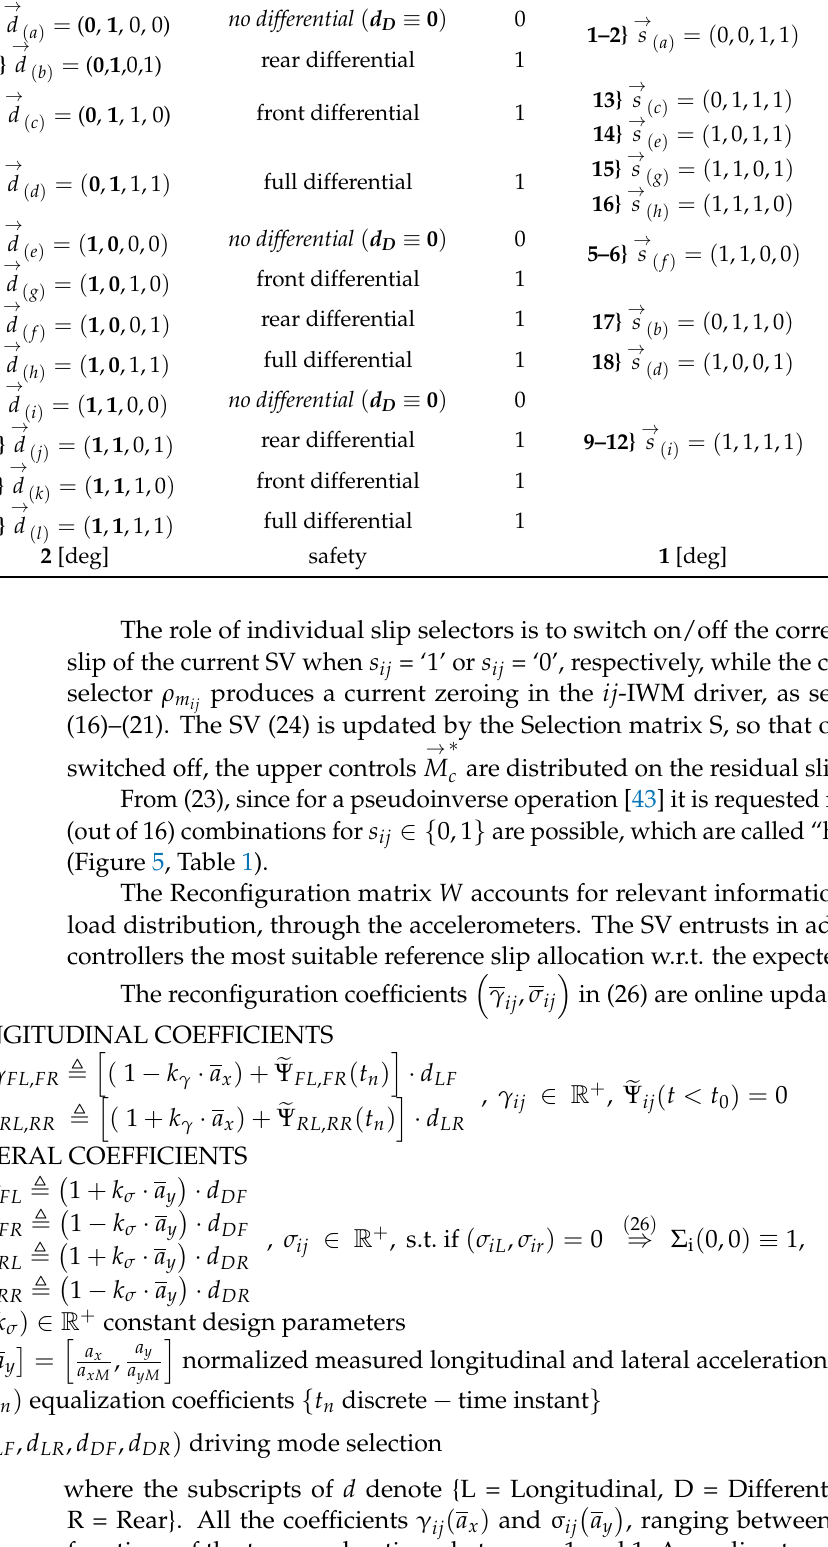
Table 1. Soft Configuration (Driving Mode Selection) and Hard Configuration: 18 settings. → d =( d LF , d LR , d DF , d DR ) Soft Configuration {LF=Long. Front, LR=Long. Rear, DF=Diff. Front, DR=Diff. Rear}